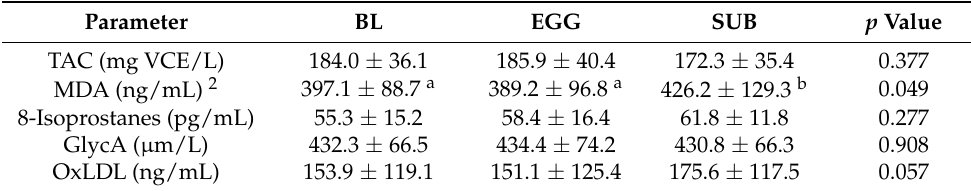
Table 2. Biomarkers for measuring oxidative stress at baseline (BL) and the end of the EGG and SUB (egg substitute) periods *.